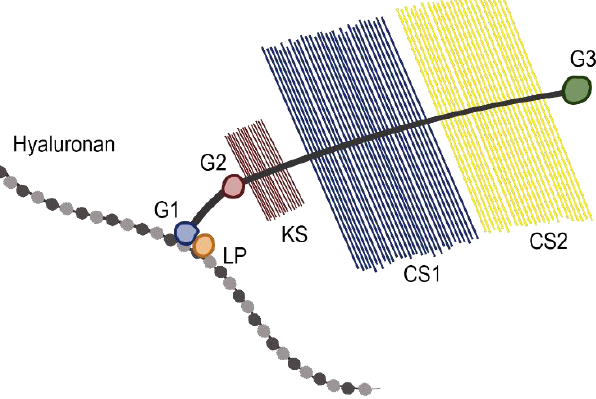
Figure 1. Structure of Aggrecan. The main protein binds to the hyaluronan backbone through G1 and link protein (LP) domains. Keratin sulfate (KS) and chondroitin sulfate (CS1 and CS2) sulfated glycosaminoglycans, which yield the net negative charge responsible for retaining water content in the tissue, are depicted.